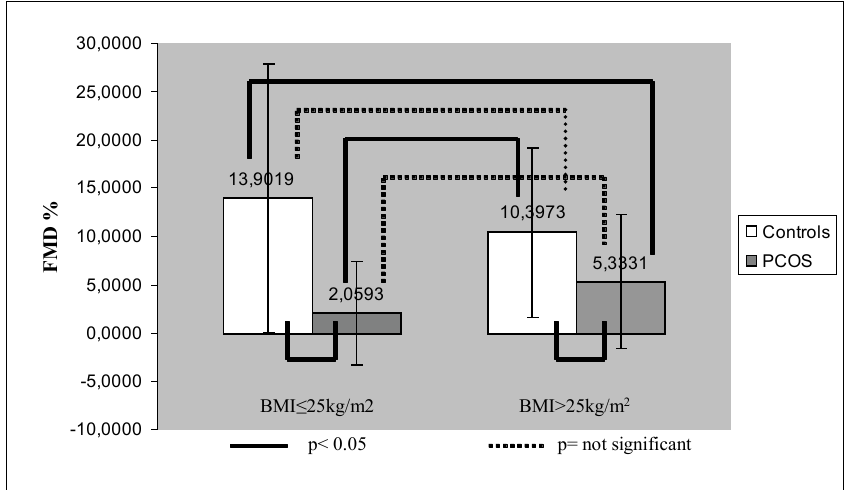
Data are given means ± SE, p<0.05 statistically significant; Figure 2. Max CIMT in PCOS and control subgroups stratified according to BMI in non-obese (BMI ≤ 25kg/m 2 ) and respectively, overweight and obese (BMI>25kg/m 2 ) subjects.